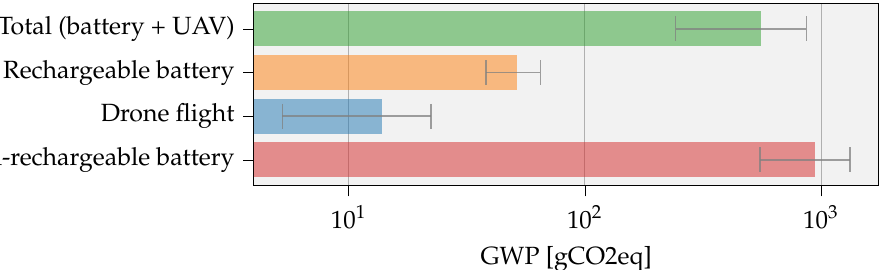
Figure 19. GWP of non-rechargeable fire-and-forget vs UAV-based servicing approach. Assumptions: 13min flight at 50Wh with lithium-based IoT node battery capacity of 2kJ and an energy consumption of 20J/day for 10years. Note the logarithmic scale.